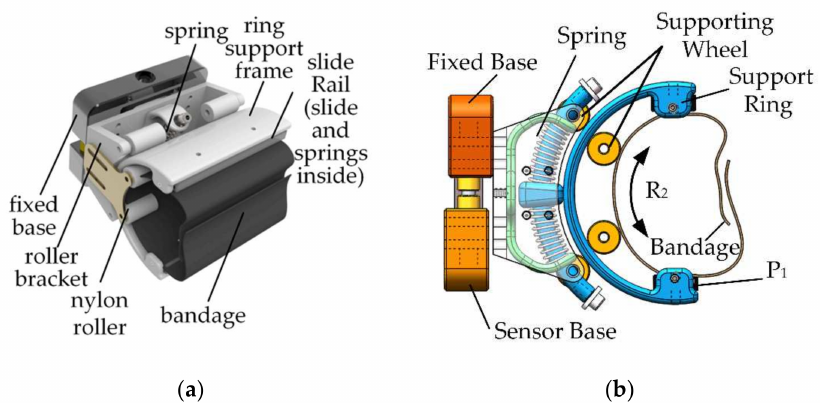
Figure 22. Forearm passive branched chain. ( a ) Three dimensional model of passive joint; ( b ) passive joint structure.